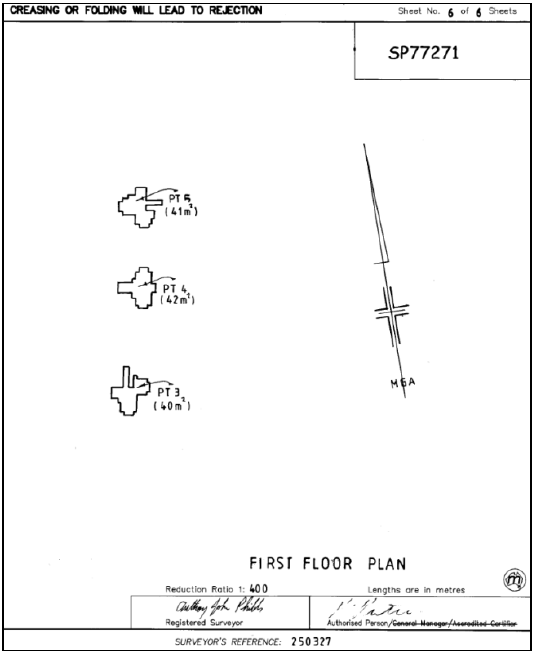
Figure 11: Floor plan not indicating location 7.2 Acronyms and other administration data are not standardised across different plans. Care needs to be